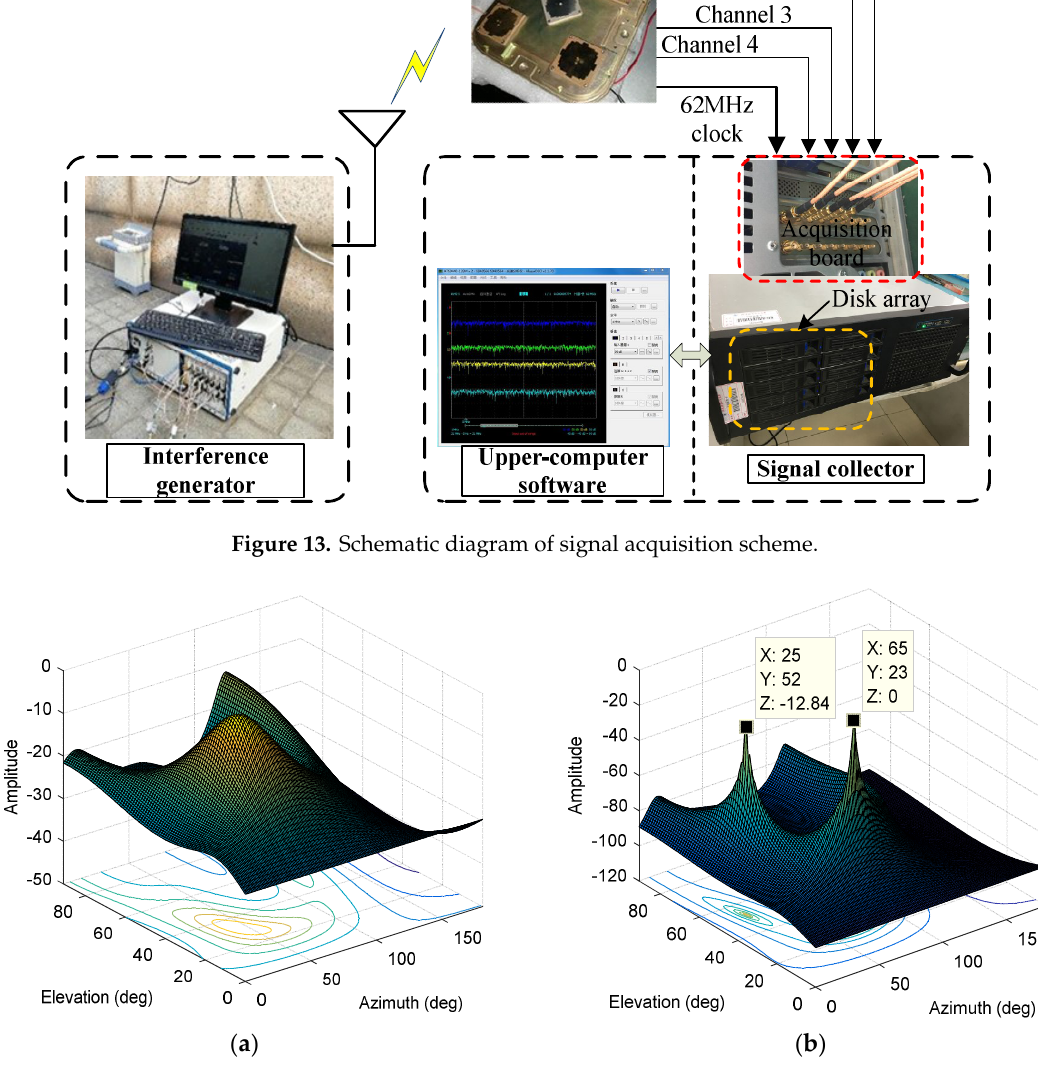
Figure 14. ( a ) The normalized spectral function derived from the MUSIC algorithm; ( b ) The normalized spectral function derived from the STC-MUSIC algorithm ( L = 4, K =